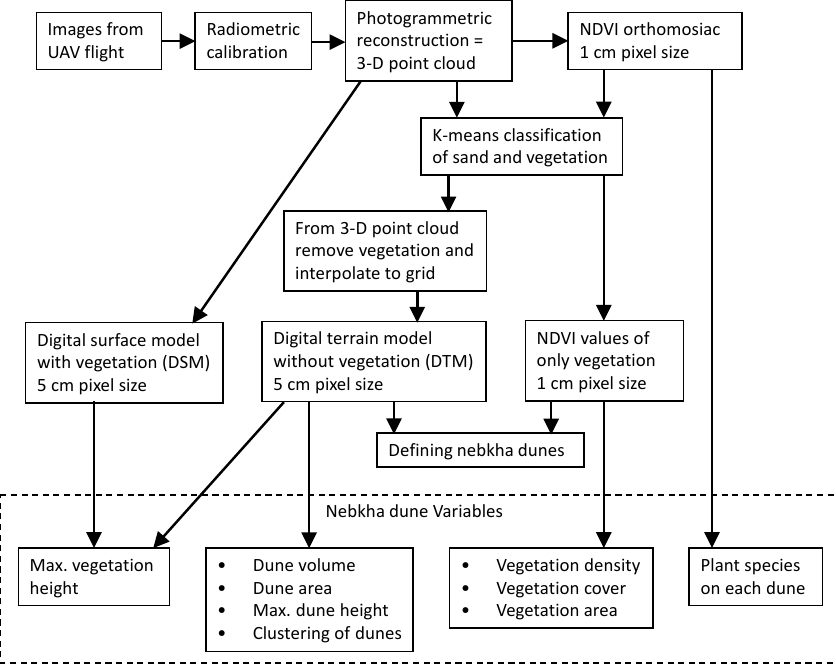
Figure 2. Workflow of the methodology. The 3-D point cloud from the photogrammetry was used to construct a DSM, DTM and NDVI orthomosaic. The DTM and NDVI orthomosaic were used to define the nebkha dunes. The explanatory variables for the statistical models were derived from the DSM, DTM and NDVI orthomosaic. For a more detailed explanation see